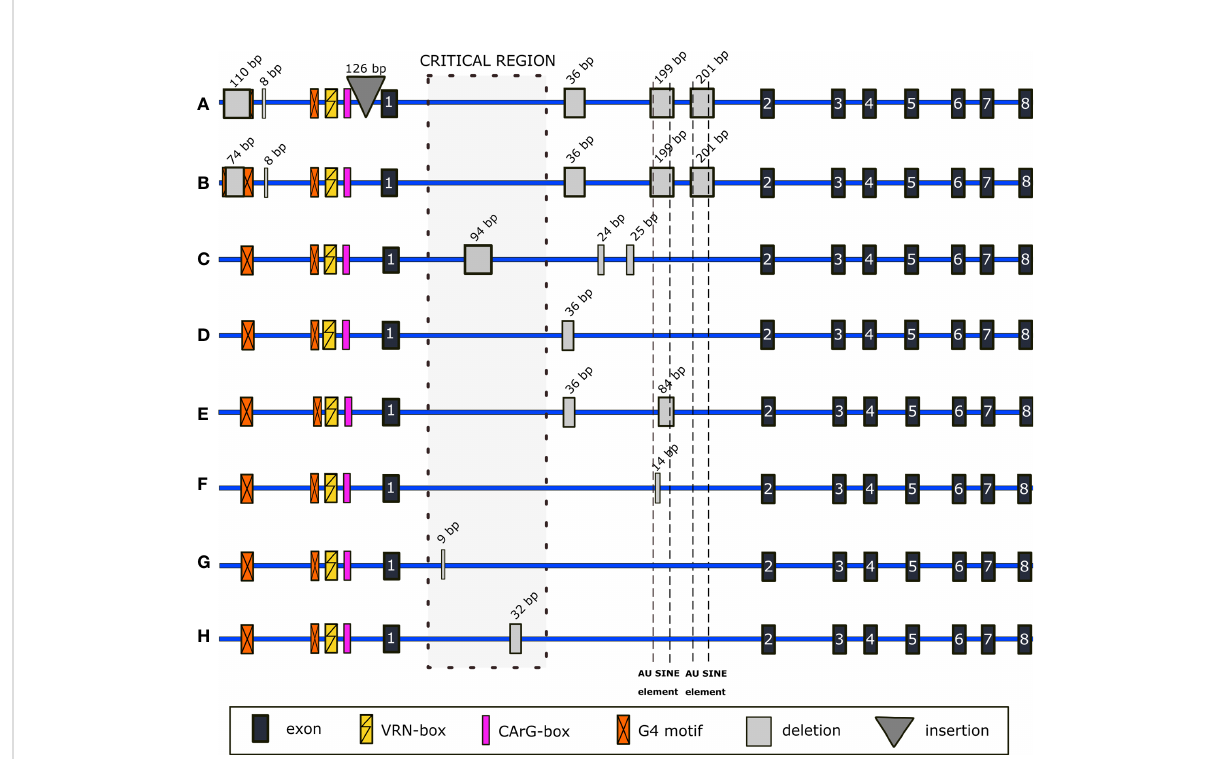
FIGURE 3 Schematic representation of selected indels detected within non-coding regions of VRN-B1 . In (A) and (C – H) , alleles with several different new indels are shown. In (B) , promoter mutations correspond to mutations described for the Vrn-G1a allele (GenBank KX344118.1) and are combined with newly found mutations of intron 1.